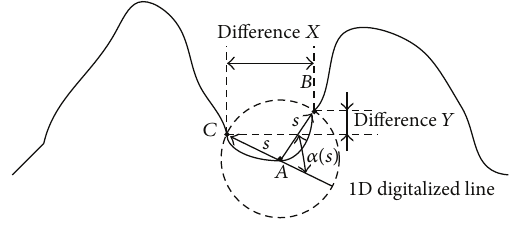
Figure 1: Schematic diagram of AMT